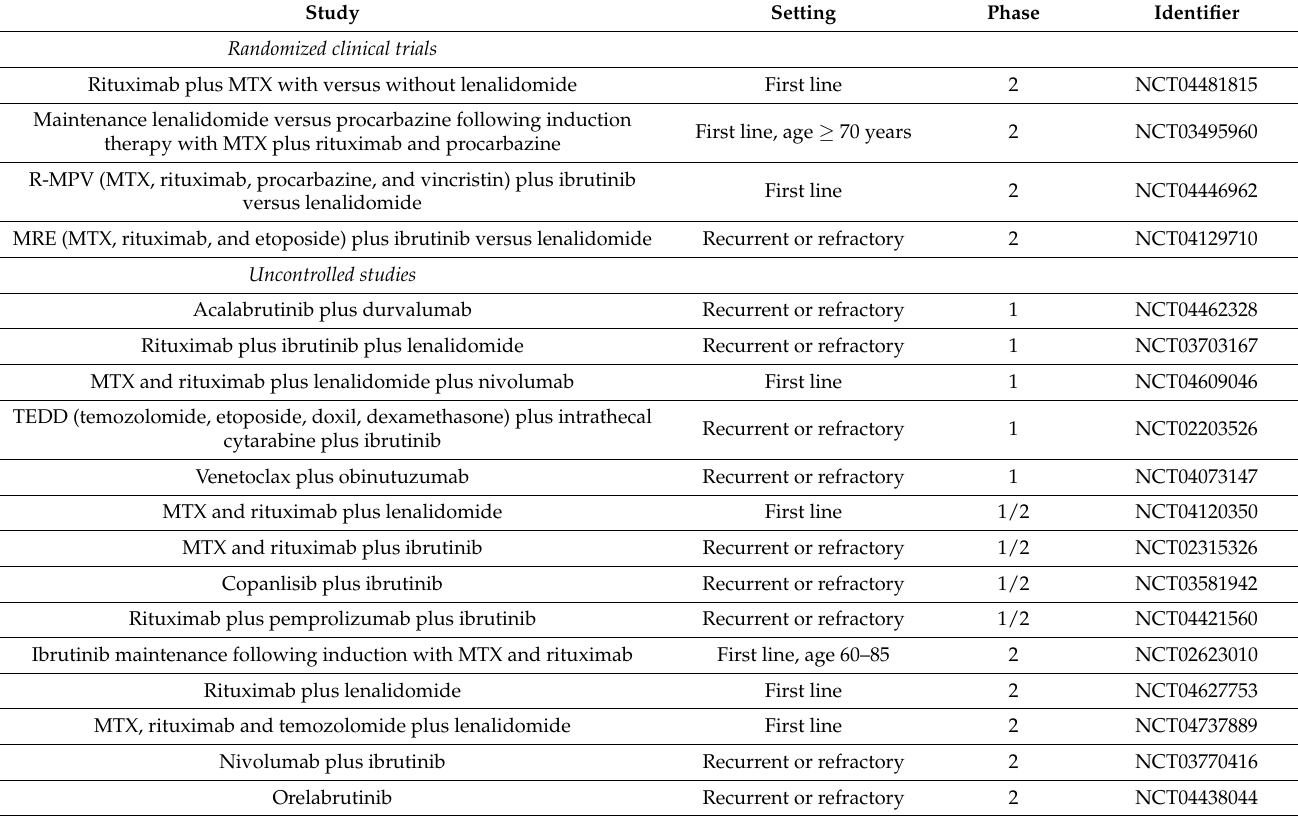
Table 1. Ongoing clinical trials of targeted therapies in